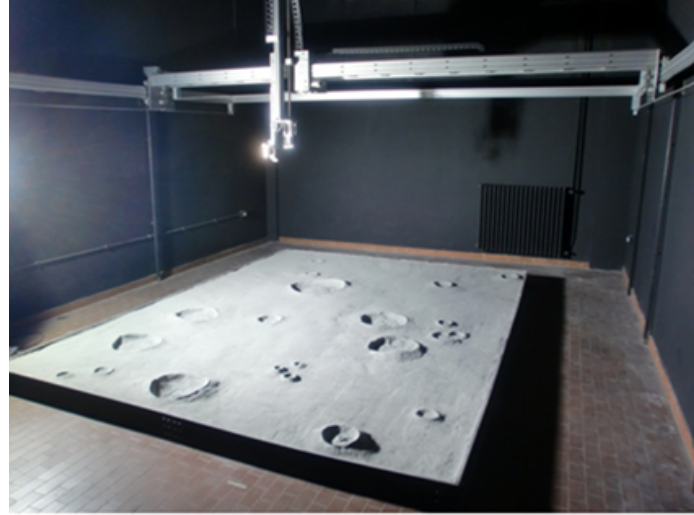
Figure 1. Experimental facility.